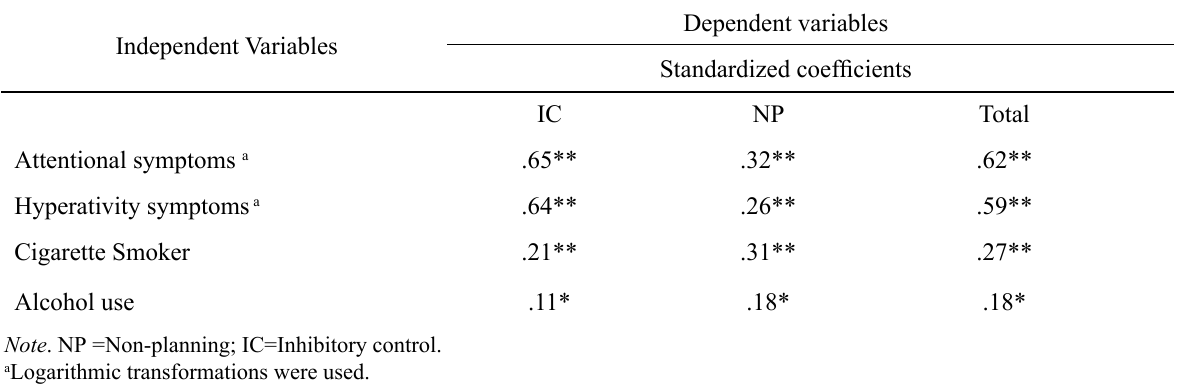
Association between BIS-11 Scores and Health